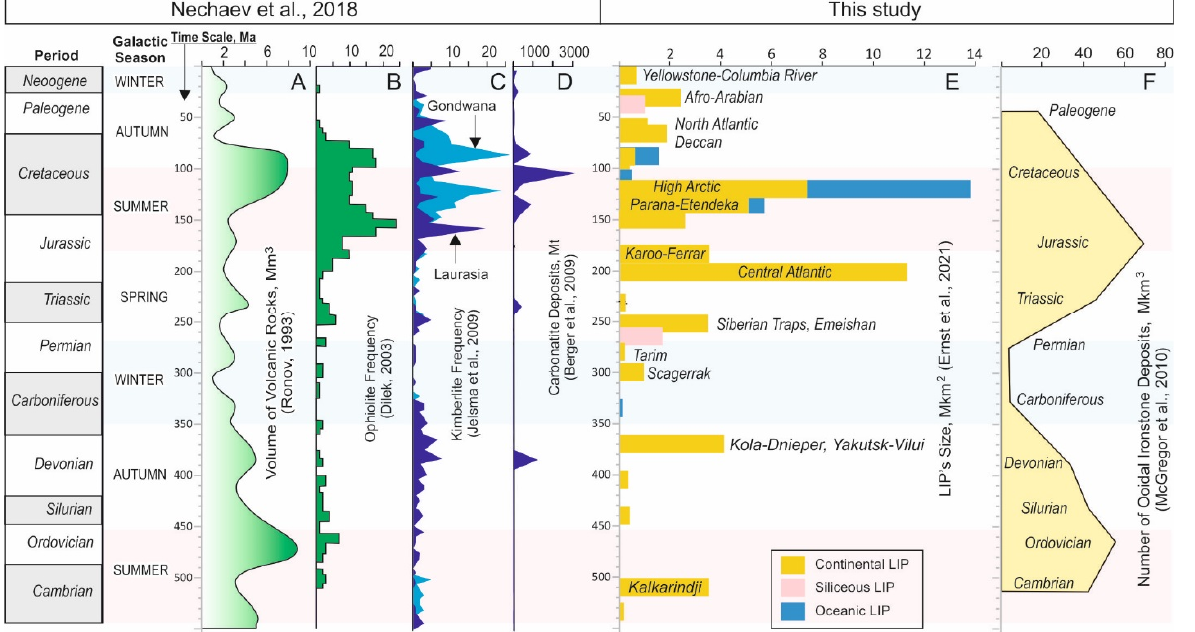
Figure 1. The proposed galactic seasons (after [2] in comparison with global changes in igneous and iron ore-forming activities (after [19–21]) with additions from [6,22]). (A)volume of volcanic rocks; ( B ) ophiolite frequency; ( C ) kimberlite frequency; ( D ) carbonatite deposits ( E ) Lip’s size ( F ) number of ooidal ironstone deposits. The LIPs names are shown only for the provinces for which geochemical data are used in this study.